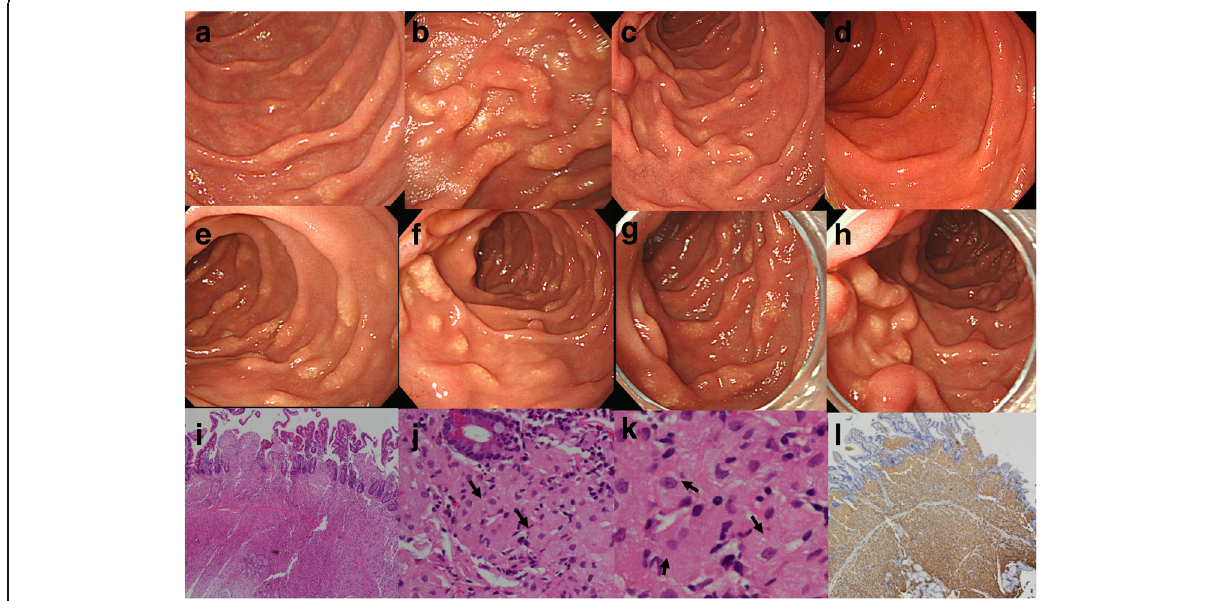
Fig. 1 Gross and pathological findings of the duodenal mucosa in Cases 1 and 2. Gaucher cell infiltration presenting with multiple yellowish nodular lesions in the upper gastrointestinal (GI) endoscopy at baseline ( a ), persistent lesions 6 months after a high dose of enzyme ( b ), slightly improving multiple nodular lesions at 6 months ( c ), and grossly improving at 12 months ( d ) after eliglustat tartrate administration in Case 1. Persistent multiple nodular lesions in Case 2 at baseline ( e , f ), and 12 months ( g , h ) after ERT. Gaucher cell infiltration in the duodenal mucosa at baseline (H&E, ×40, ×200, ×400) ( i , j , k ). Gaucher cells are strongly positivity for CD68, which is a special stain for macrophages and Gaucher cells (CD68, ×40) ( l